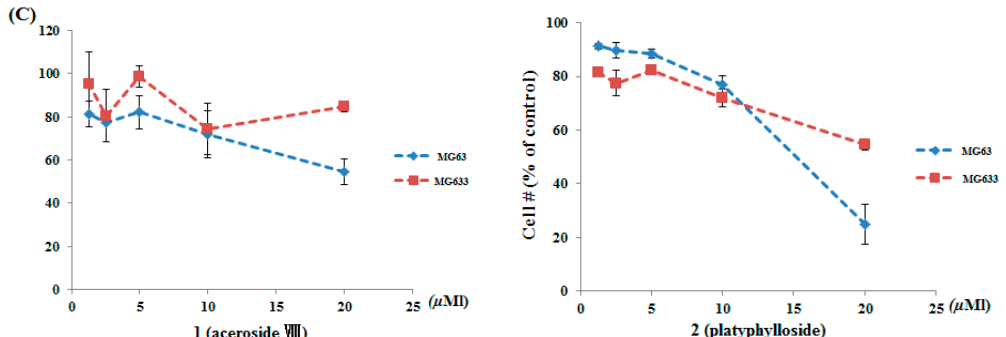
Figure 5. Cytotoxicity of compounds aceroside VIII ( 1 ) and platyphylloside ( 2 ) in colon tumor cells COLO205, KM12 ( A ) renal tumor cells A498, U031 ( B ) and osteosarcoma cells MG63 and MG63.3 ( C ). Cell proliferative activity was determined by XTT assay, and data are the mean ± SD of the percentage of cell proliferation from three independent experiments.